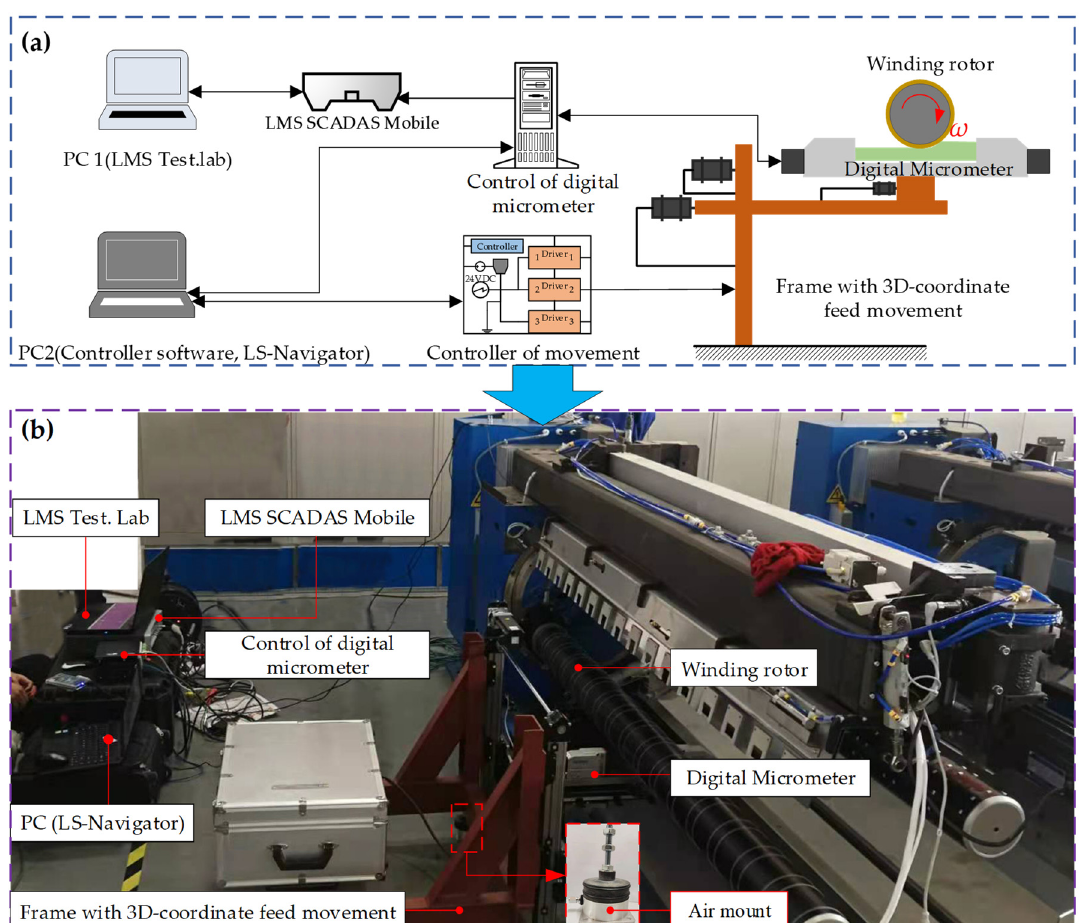
Figure 10. Experimental test of the winding rotor. ( a ) Experimental scheme; ( b ) measuring device.